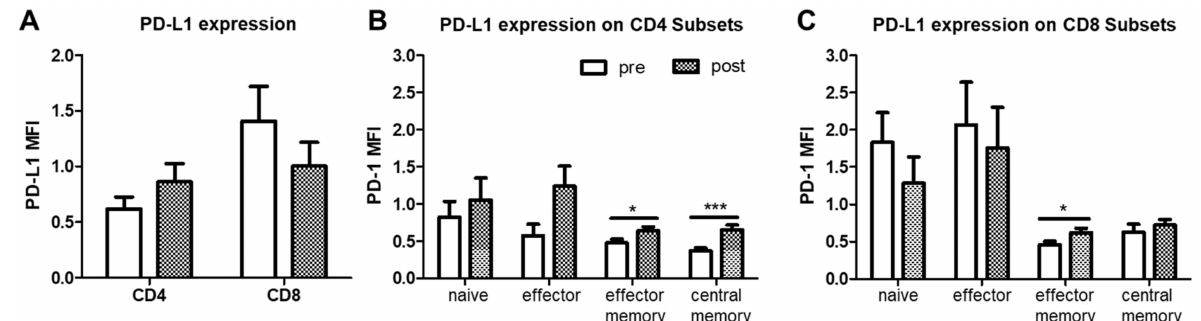
Figure 7. Flow cytometric analysis of CD4 + and CD8 + T cell subsets in PBMC from OSA patients ( n = 22) before and after PAP treatment. ( A ): PD-L1 expression intensity (MFI) whole CD4 + or CD8 + T cell subsets. ( B ): PD-L1 expression intensity (MFI) on naïve, effector, effector memory and central memory T cells within CD4 + T cells. ( C ): PD-L1 expression intensity (MFI) on naïve, effector, effector memory and central memory T cells within CD8 + T cells. MFI = Mean fluorescence intensity. *: p < 0.05; ***: p < 0.001.